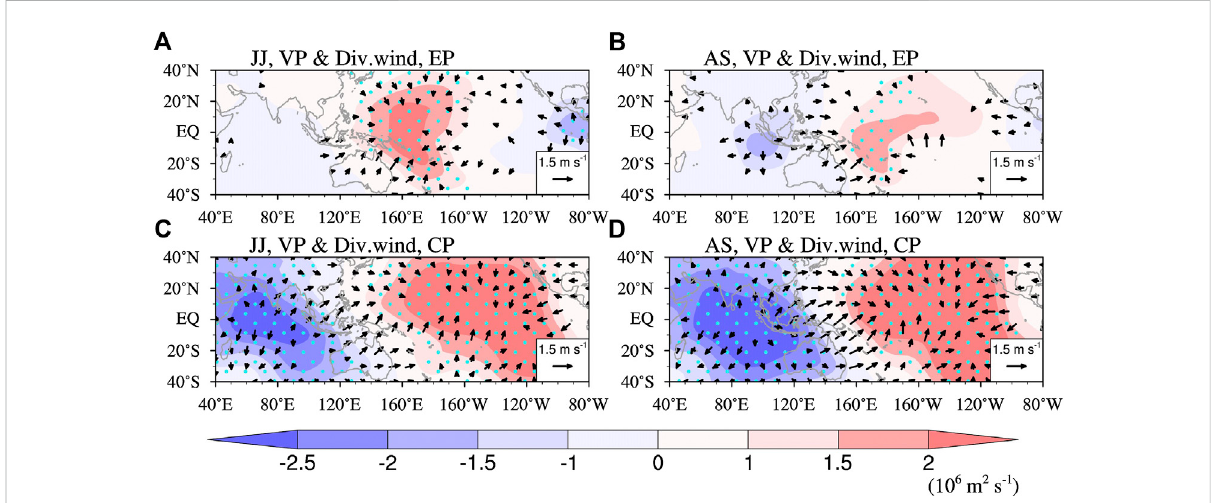
FIGURE 4 (A) June – July(JJ)and (B) August – September(AS)verticalshearofthedivergencewind(vectors;units:m − 1 )andvelocitypotential(VP,shading; units:106 m 2 s − 1 )anomalies between 200and850hPafor decaying easternPaci fi c(EP)ElNiñoevents. (C) and (D) arethesameas (A) and (B) ,butfor CP El Niño events. Only vectors with magnitudes greater than 0.2 m s − 1 are shown; cyan dots indicate relative vorticity anomalies above the 80% signi fi cance level.